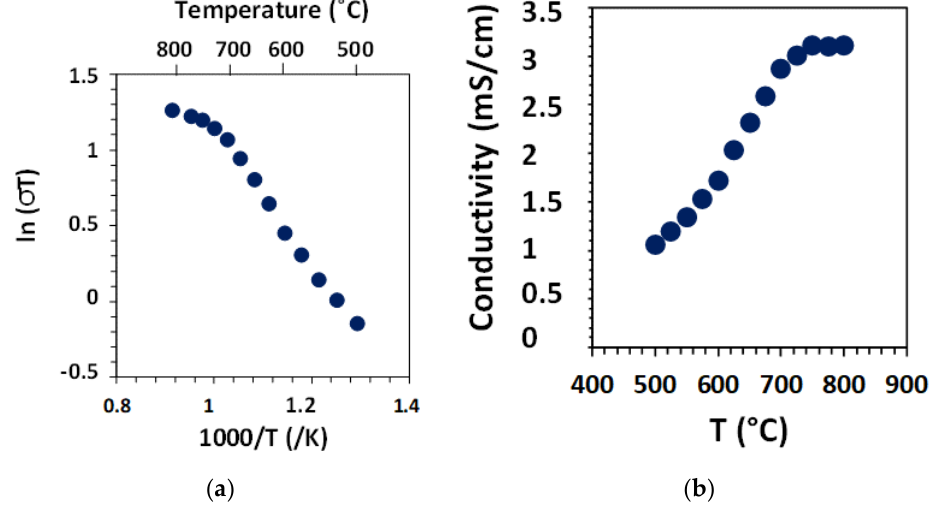
Figure 7. Bulk conductivity on a BZCY755 specimen ( a ), with BZCY755/Ni electrodes ( b ) in 3% moist 10% H 2 balanced argon.